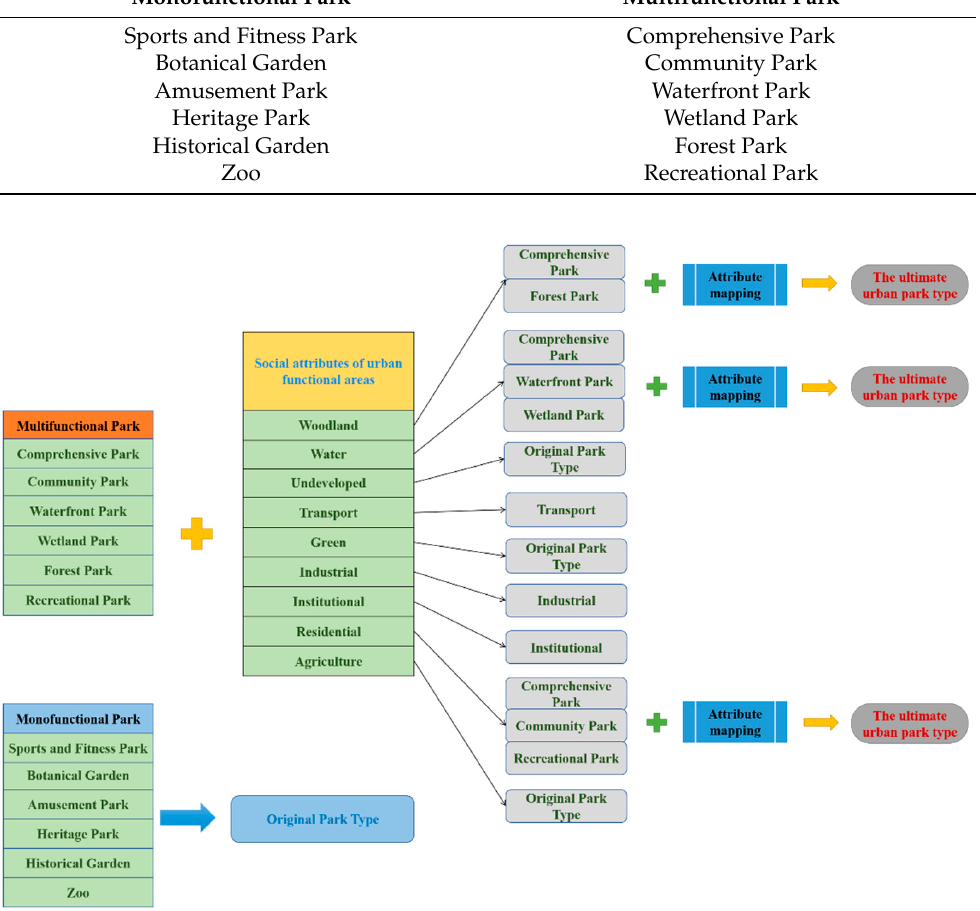
Figure 12. Social attribute determination flow